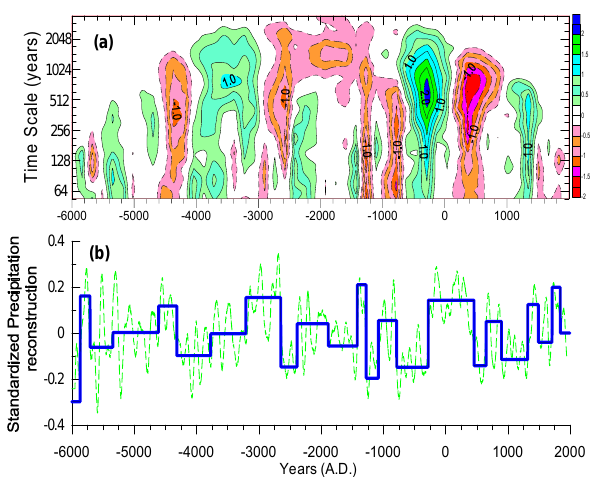
Fig. 3. (a) Contours of the normalized scanning t -test for the pre- cipitation reconstruction series at confidence level 95%. Contour interval is 0.25 but the zero-contour is hidden. Solid lines denote positive values, dashed lines negative values. (b) Change points and episode averages (solid line) from panel (a), 101-year Gaussian fil- tering of the precipitation reconstruction (dashed line), the average over the entire time series is zero after